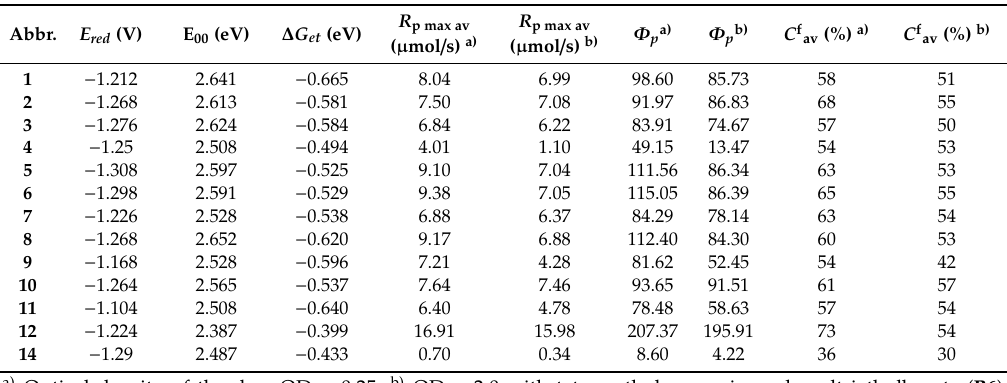
Figure 5. Family of kinetic curves recorded during the measurements of the heat flow emitted during the photoinitiated polymerization of trimethylolpropane triacrylate (TMPTA) initiated by merocyanine borate systems marked in the figure. The borate salt concentration was 5 × 10 − 2 M, optical density of the dyes was 0.25 at an excitation wavelength, I 0 = 100 mW / cm 2 . Table 2. Reduction potential of the merocyanine dyes ( E red ), singlet state energy ( E 00 ), free energy of activation for the photoinduced electron transfer (PET) process ( ∆ G et ), average maximal rates ( R p max av ), average quantum yields ( Φ p ), and average final double bond conversion ( C f av ) of TMPTA radical polymerization for tested photoredox